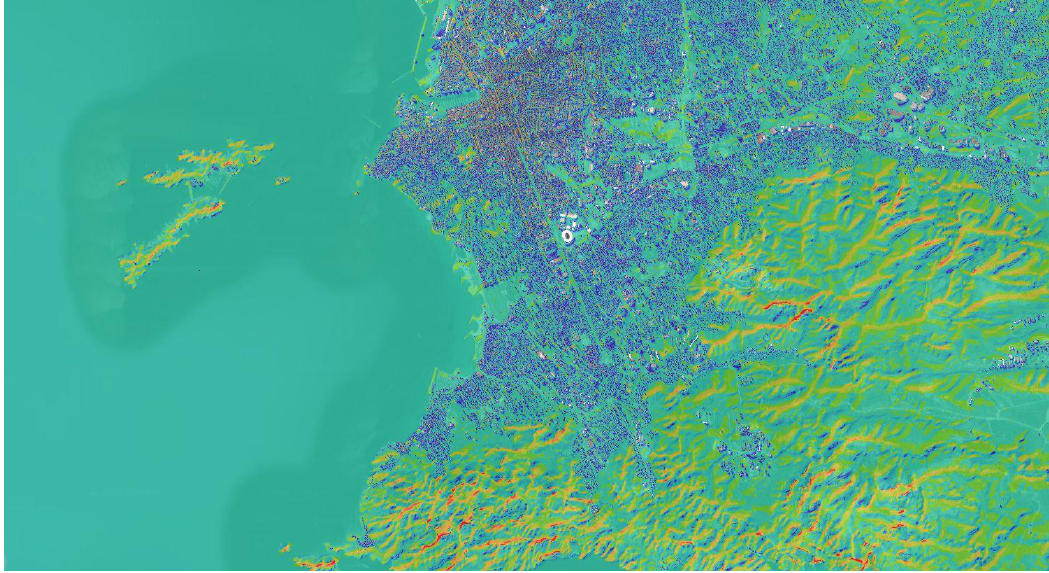
Figure 7. View of the wind speed in the Marseille city center and on the topography south of the city. North is at the top.